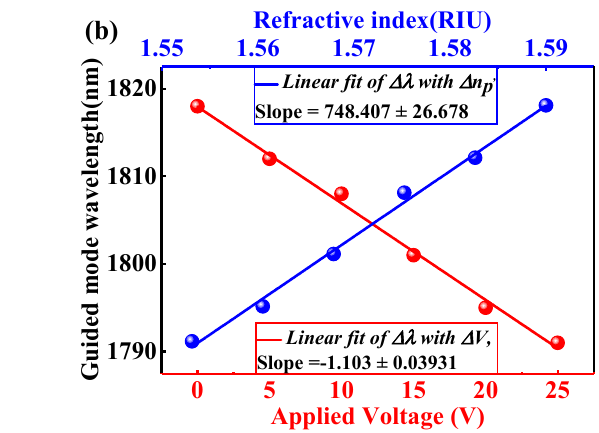
Figure 7. Group velocity (𝑣 (cid:3034) /𝑐) for TM guided mode with the normalized frequency 𝑈 = 𝜔𝑎/2𝜋𝑐 = 𝑎/𝜆 for 2-D calculations with 𝑛 (cid:3032)(cid:3033)(cid:3033) = 3.2 approximation and 𝑛 (cid:3029)(cid:3048)(cid:3039)(cid:3038) = 3.48 of the opti- mized mode at 𝑙 = 1.50𝑎 .